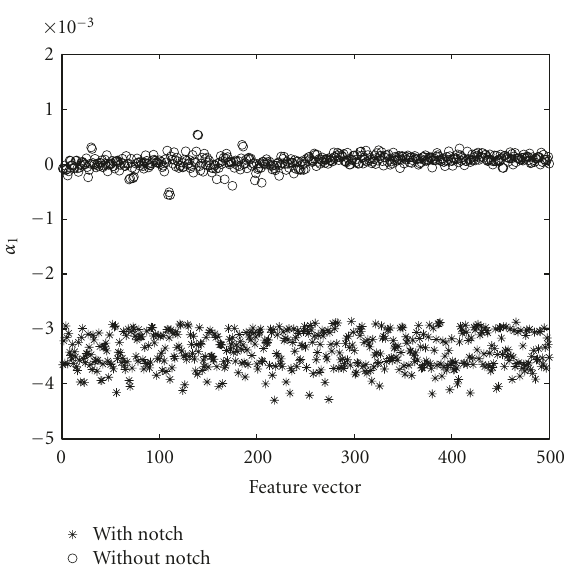
Figure 24: HOS-based features extracted from u to classify the notch disturbance, α = (cid:21) c 2, u (97).